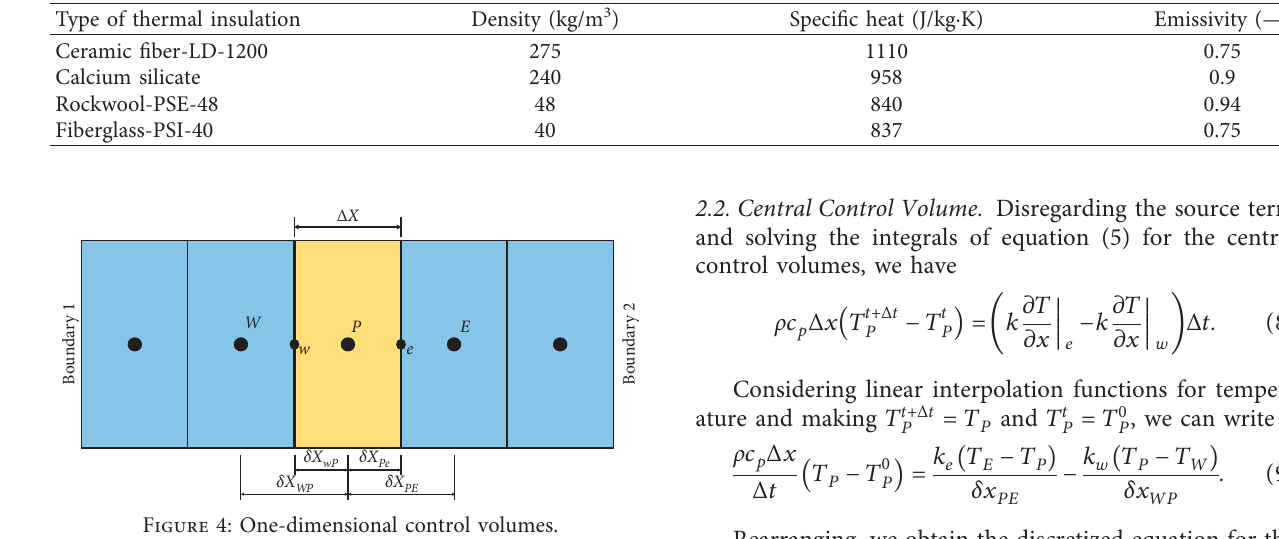
Table 2: Some thermophysical parameters of the thermal insulators.